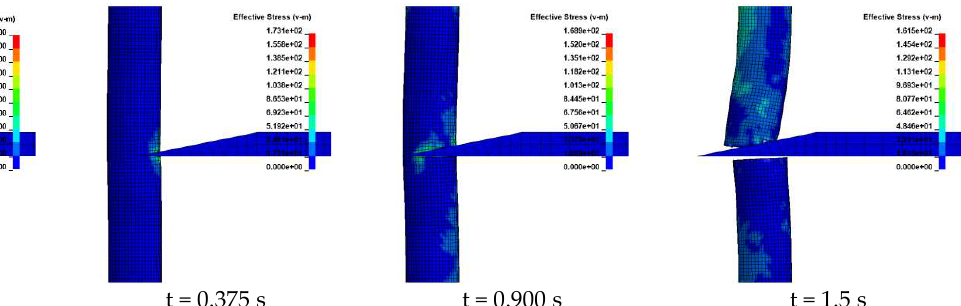
Figure 11. Simulation results graph.